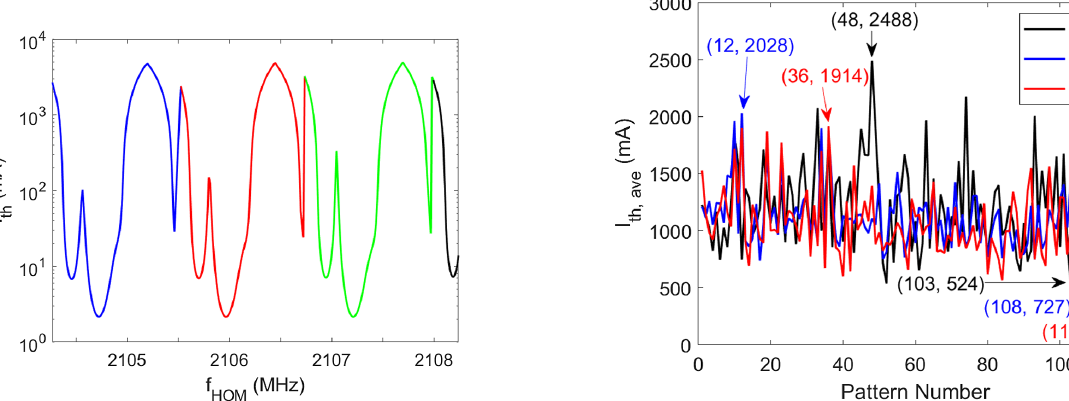
FIG. 8. Frequency averaged threshold current 120 SP patterns for μ ¼ 1 . 5 π . The black, red, and blue curves are the results with 1 T 5 T 10 T rf , rf , and rf bunch spacings,